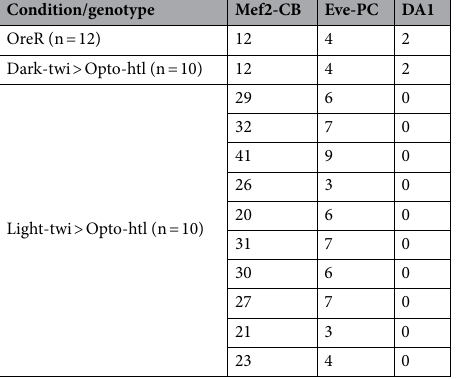
Table 1. Number of Mef2-positive cardioblasts, Eve-positive pericardial cells and DA1 muscles in OreR, twi ::Gal4 > Opto-htl (dark) and twi ::Gal4 > Opto-htl (illuminated) embryos. Cells were counted at stage 15/16 from hemisegments